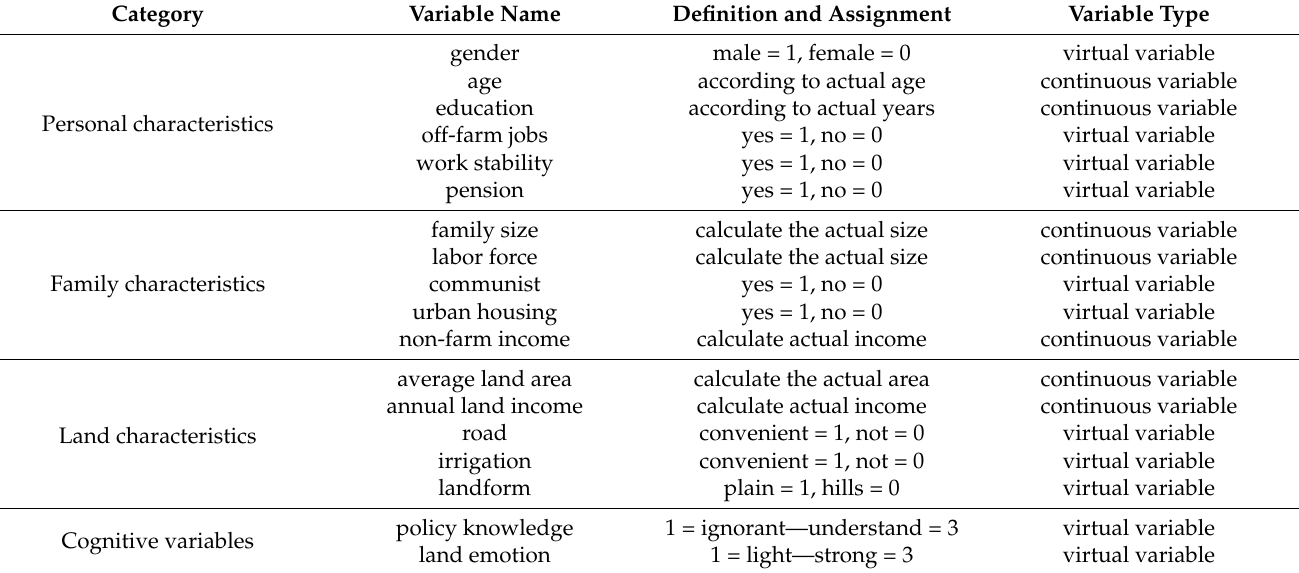
Table 2. Variable definitions and assignments.